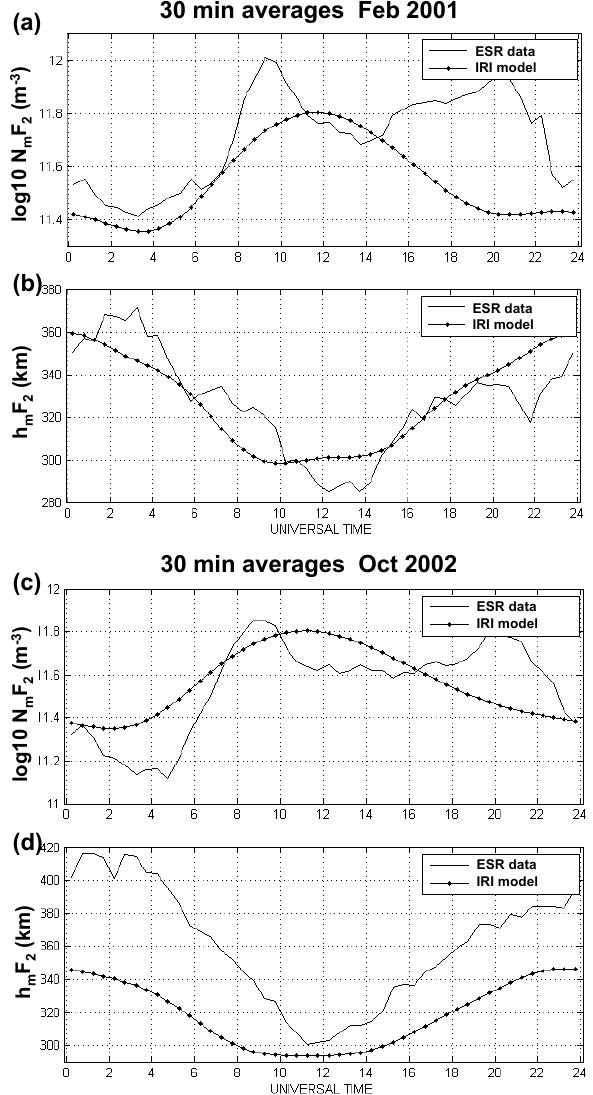
Fig. 4. (a) A comparison between averaged N m F 2 data derived from ESR (full line) and the corresponding values from the IRI2001 model (full line with dots), for the month of February 2001. (b) ESR and IRI model curves of h m F 2 corresponding to the N m F 2 density curves in panel (a). (c–d) Similar to (a–b) but for October